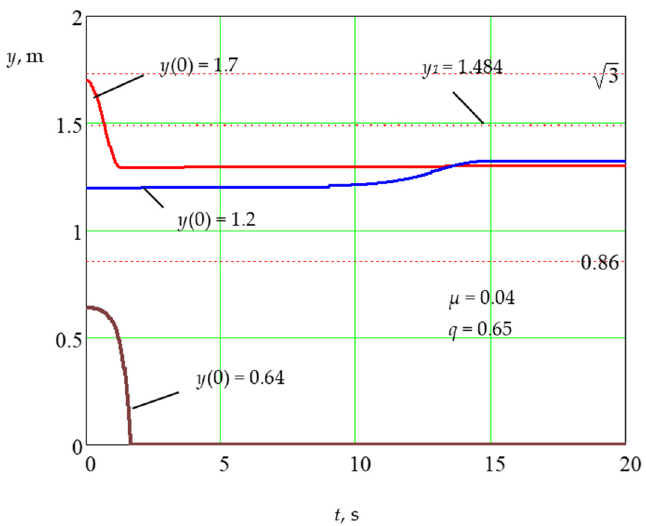
Figure 14. Movement of the system with a further increase in the coefficient of friction from different initial points with a stiffness of the thread sufficient for the occurrence of free vibrations.